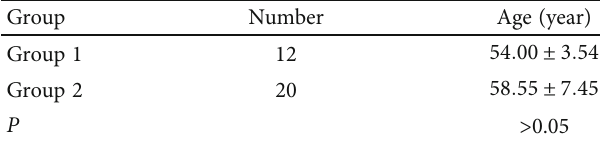
Table 1: Age information of the enrolled